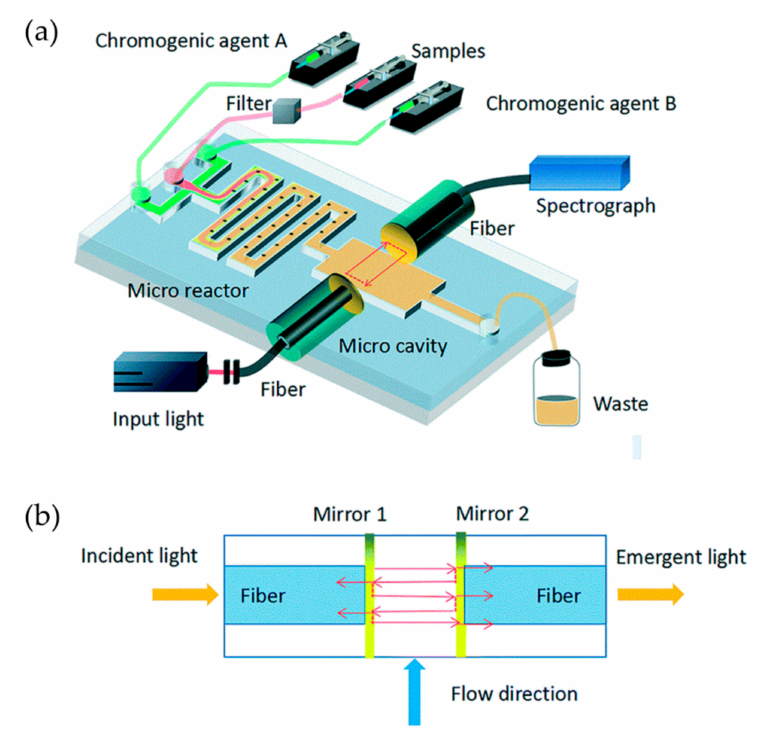
Figure 5. A Fabry–P é rot resonator-based optofluidic device used for monitoring of phosphate in oceans. ( a ) Setup of the optofluidic device. Microchannels with crescent batteries are designed for rapid and enough mixing of regents. ( b ) The microcavity is formed by a pair of optical fibers, on which surfaces are coated with gold. Images reproduced from